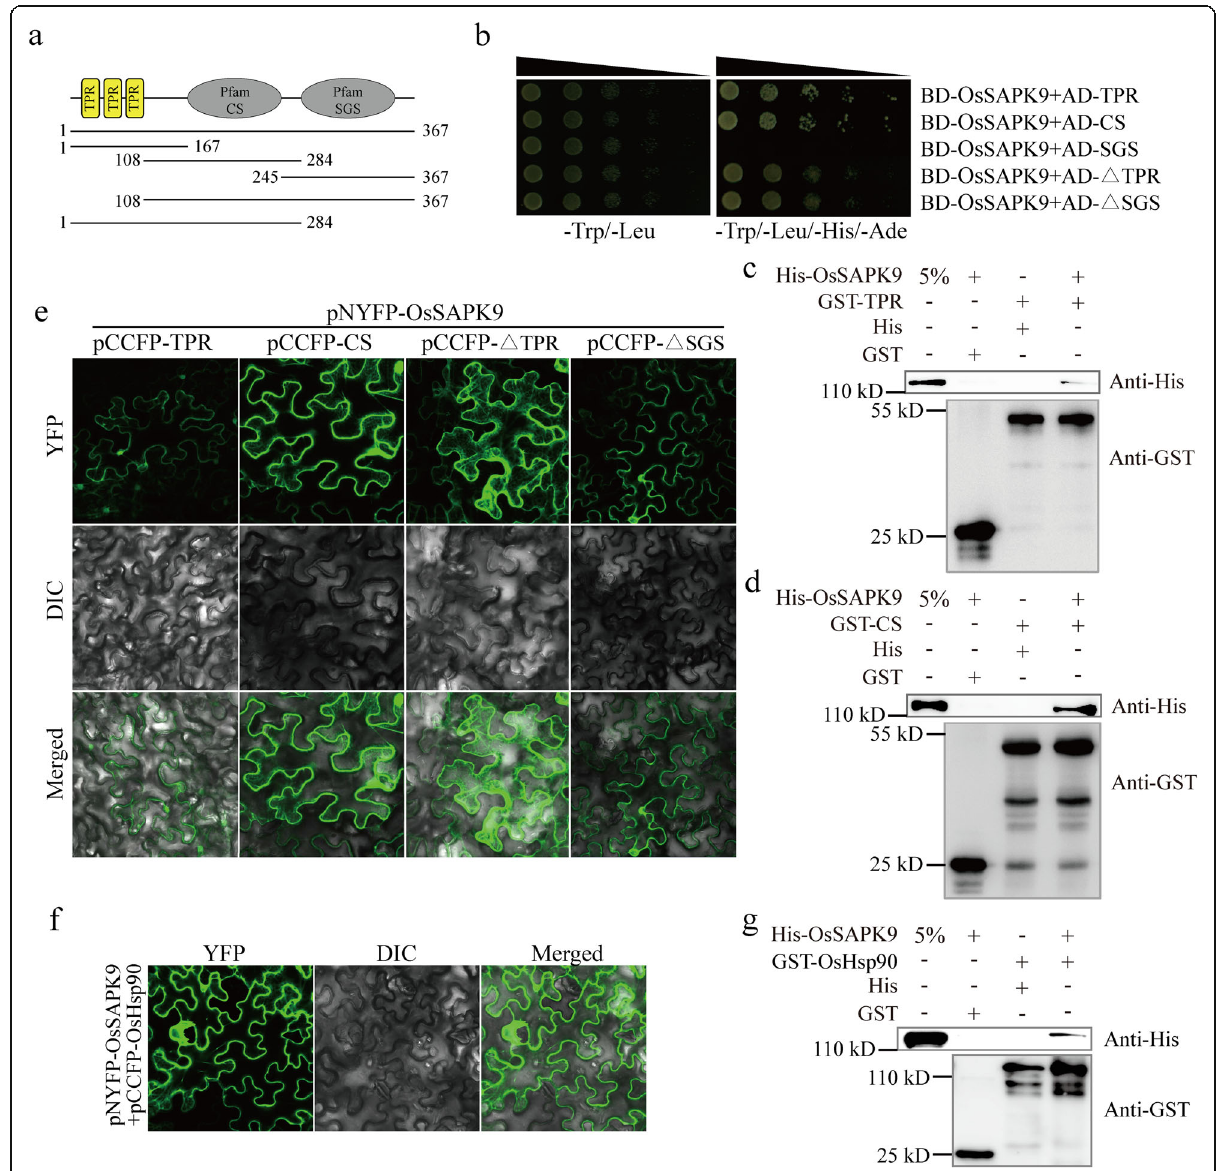
Fig. 4 OsSAPK9 interactions with different OsSGT1 domains in vitro and in vivo. a Schematic of the functional domain of OsSGT1. Positions of the tetratricopeptide repeat (TPR) domain (1 – 167 amino acids), the CHORD-containing protein and SGT1 (CS) domain (108 – 284 amino acids), the SGT-specific (SGS) domain (245 – 367 amino acids), the Δ TPR domain (108 – 367 amino acids), and the Δ SGS domain (1 – 284 amino acids) are indicated. b OsSAPK9 interactions with the TPR and CS domains in yeast. The TPR, CS, SGS, Δ TPR, and Δ SGS domains are from OsSGT1. AH109 yeast transformants diluted 10, 100, 1000, or 10,000 times were plated on synthetic dextrose (SD) medium lacking Trp and Leu amino acids (SD − L/T) or SD medium lacking Trp, Leu, His and Ade amino acids (SD − L/T/W/A). c OsSAPK9 bound to the TPR domain of OsSGT1 in the glutathione S-transferase (GST) pull-down assay involving His-OsSAPK9 and GST-TPR. d OsSAPK9 bound to the CS domains of OsSGT1 in the glutathione S- transferase (GST) pull-down assay involving His-OsSAPK9 and GST-CS. e OsSAPK9 interactions with the TPR and CS domains in a bimolecular fluorescence complementation assay. OsSAPK9 was fused to an N-terminal yellow fluorescent protein (NYFP-OsSAPK9), and TPR, CS, SGS, Δ TPR, and Δ SGS were fused to C-terminal cyan fluorescent proteins (CCFP-TPR, CCFP-CS, CCFP-SGS, CCFP- Δ TPR, and CCFP- Δ SGS). f OsSAPK9 interactions with OsHsp90 in the bimolecular fluorescence complementation assay. OsSAPK9 was fused to an N-terminal yellow fluorescent protein (NYFP-OsSAPK9), and OsHsp90 was fused to a C-terminal cyan fluorescent protein (CCFP-Hsp90). g OsSAPK9 bound to OsHsp90 in the GST pull-down assay involving His-OsSAPK9 and